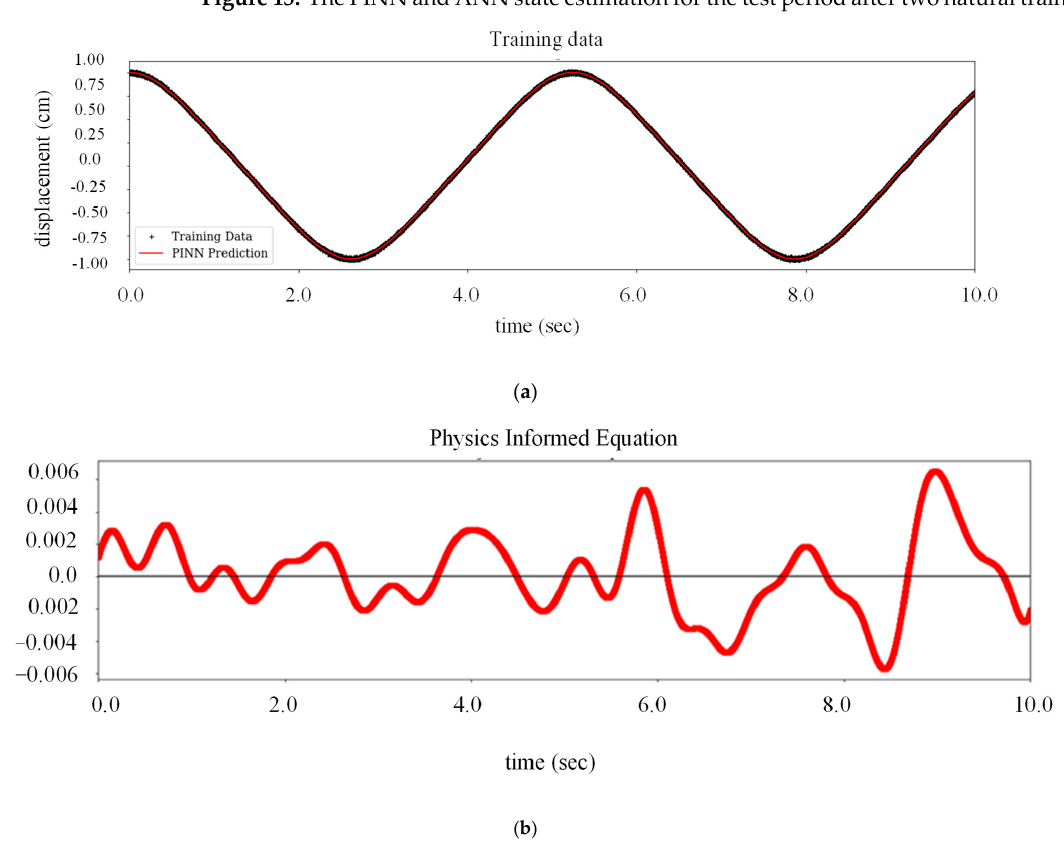
Figure 16. Physic equation satisfaction of the PINN during two natural training periods: ( a ) input data consistency; ( b ) physics equation satisfaction 0*.